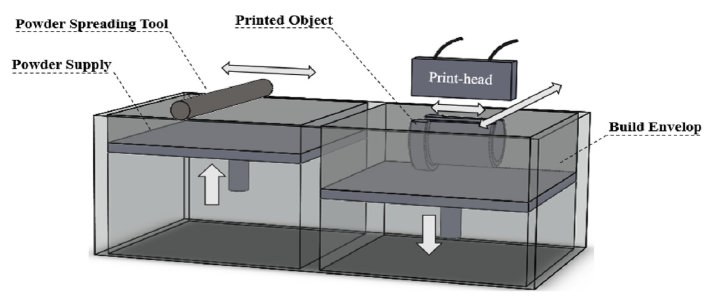
Figure 11. Illustration of the general BJ printing process. (Reprinted from Additive Manufacturing , Volume 28, Mohsen Ziaee and Nathan B. Crane, Binder jetting: A review of process, materials, and methods, 781–801, Copyright (2019), with permission from